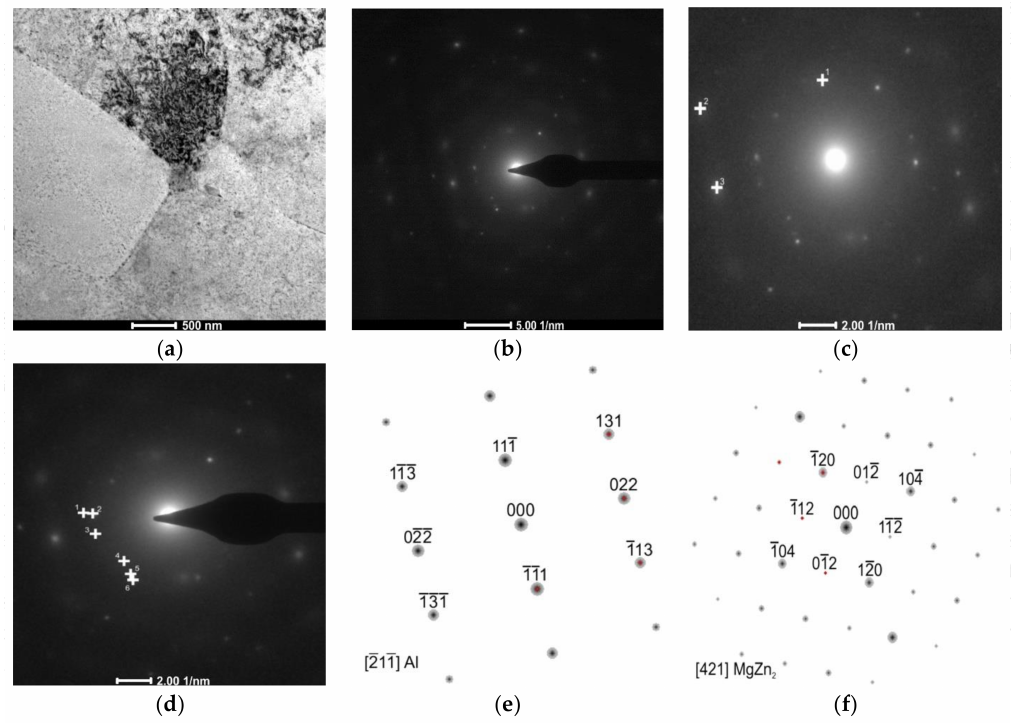
Figure 7. The AlZn6Mg0.8Zr alloy after LTTT with 10% deformation: ( a ) stochastically distributed precipitates in the substructure; ( b ) electron diffraction; ( c ) marked reflections of α solution matrix; ( d ) marked reflections of MgZn 2 ; ( e ) solution of α phase matrix diffraction and ( f ) solution of MgZn 2 phase